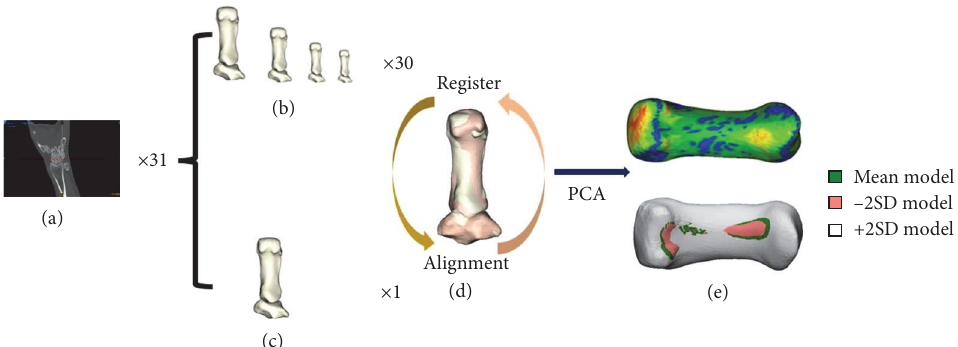
F IGURE 1: Overview of the process for the statistical model generation. (a) A set of training CT images. (b) Simulated and meshed 3D resource models. (c) The template 3D model. (d) The resource models register and alignment to the template model. (e) The distance map between the mean model, − 2SD model, and + 2SD model after